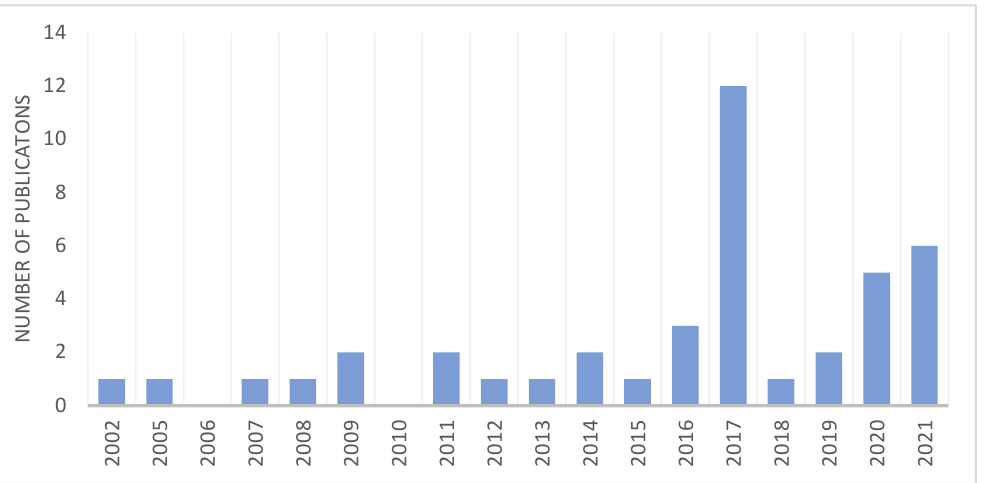
Figure 4. Number of publications per year from 2002 to 2021. Publications related to the search topic from Scopus and WOS.